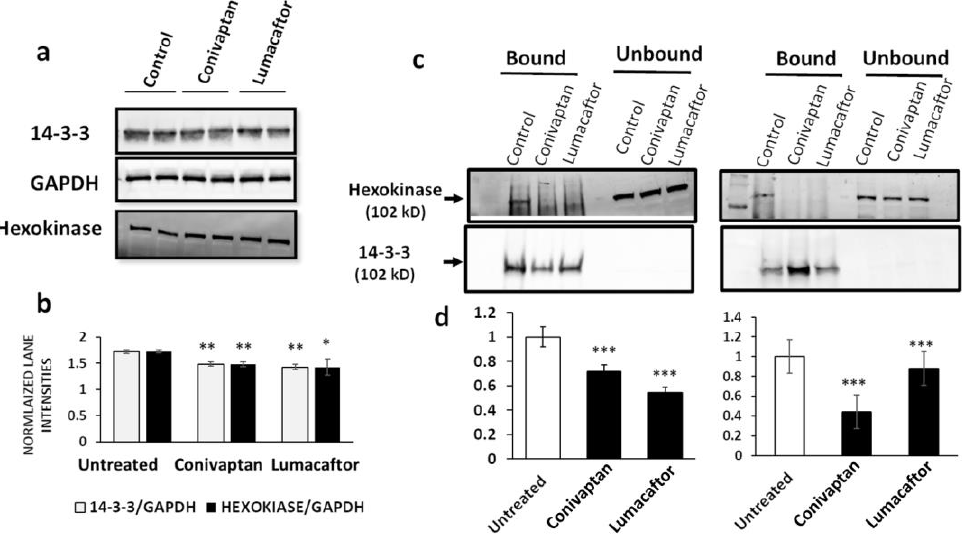
Figure 8. Hexokinase interacts with one or more 14-3-3 proteins in human neuroblastoma cells. ( a ) Acrylamide gels were loaded with 50 µ g total protein per lane extracted from SH-SY5Y-APP Sw cells after a 48 h exposure to FDA-approved drugs lumacaftor or conivaptan. Western blots were probed with antibodies to the 14-3-3 conserved core, hexokinase, or GAPDH. ( b ) Mean ± SD band intensities of hexokinase lanes ( N = 3) normalized to the corresponding 14-3-3 band. ( c ) Antibody to the 14-3-3 conserved core was used for immunopulldown of 14-3-3 complexes from neuroblastoma cells either treated for 48 hr with drugs or untreated. Gel lanes were loaded with protein recovered from coated magnetic beads and electrophoresed, and western blots were probed to detect hexokinase or 14-3-3 proteins. ( d ) Histogram of hexokinase recovery (signals on western blots as in ( c )), normalized to 14-3-3; the band signal is plotted for mean ± SD band intensity ratios of replicates. Significances according to two-tailed heteroscedastic t -tests ( b , d ), each N = 4: * p = 0.05; ** p < 10 − 2 ; *** p < 10 − 3